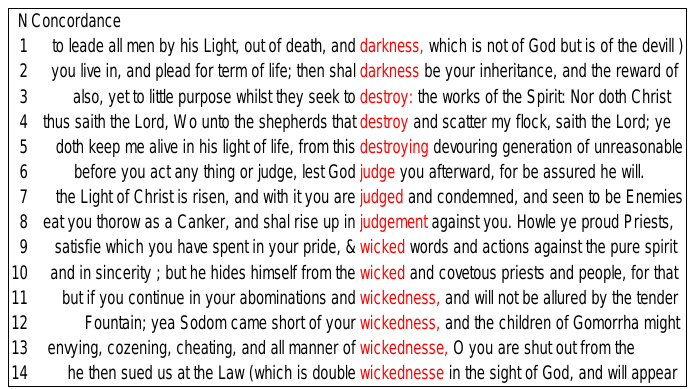
Figure 2. Example concordances lines, in Qcorpus1 for: DARK, DESTROY, JUDGE, and WICKED.